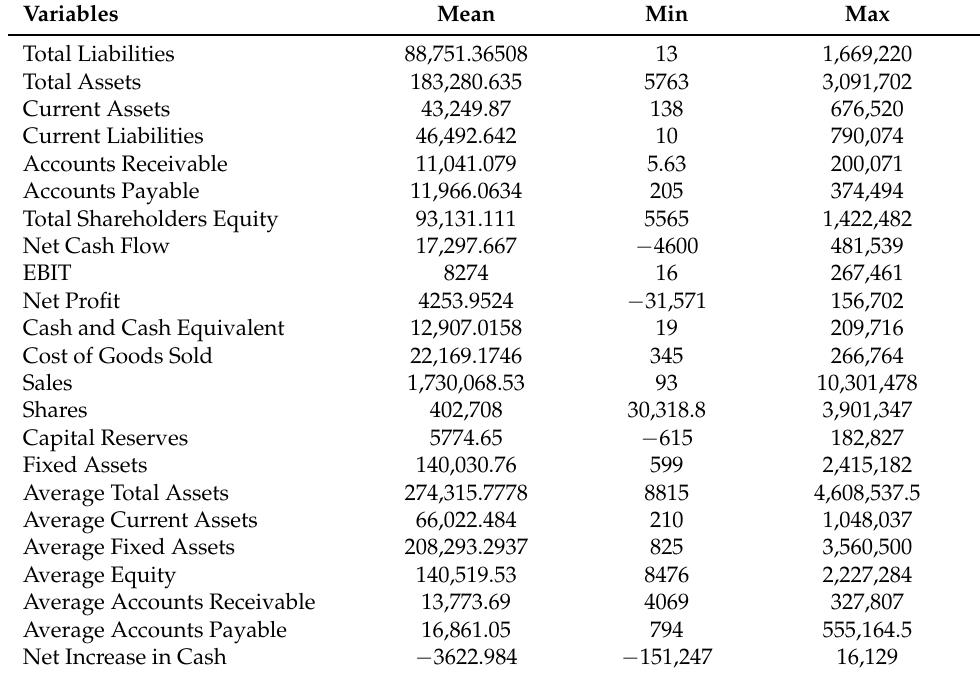
Table 2. Descriptive statistics of all individual financial